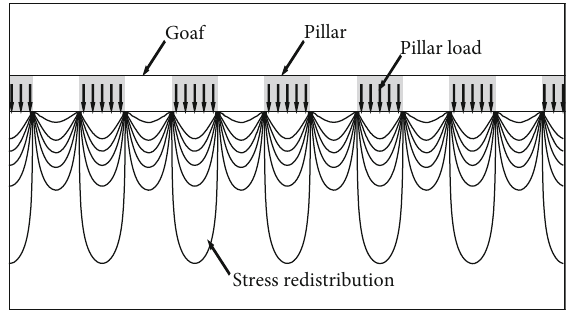
Figure 4: Simpli fi ed model diagram of the stress redistribution after strip mining.